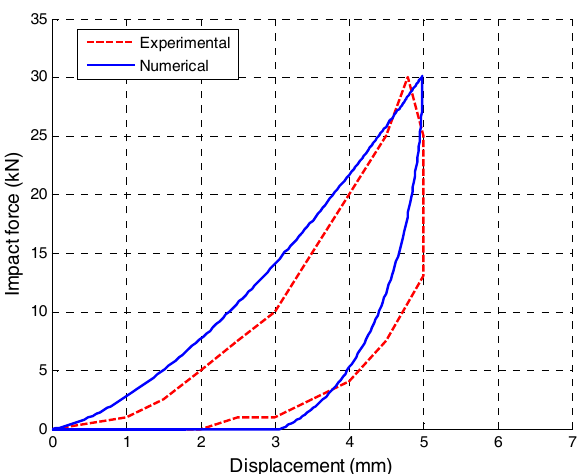
Figure 7. Experimentally and numerically determined relation between impact force and displacement during impact between two steel frames.